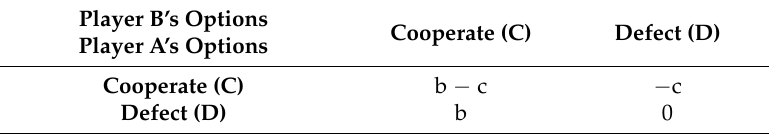
Table 1. Payoffs player A obtains in donation game.